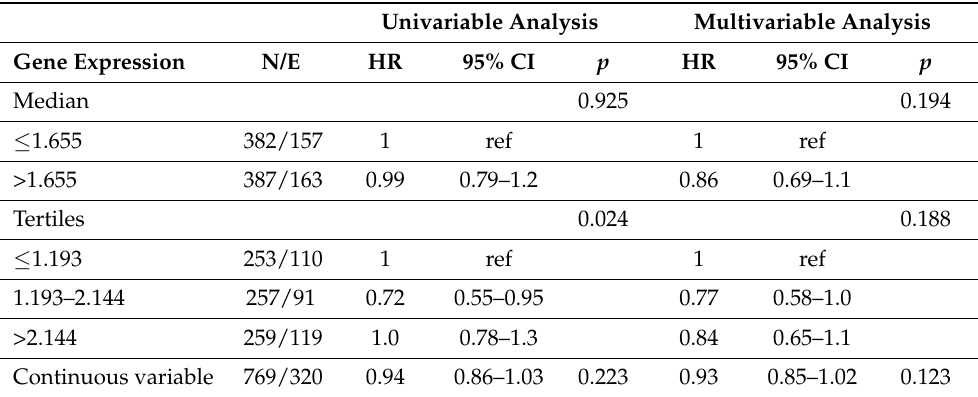
Table 13. Event Free Survival of 769 NB patients in relation to RSAD2 expression levels evaluated by the Cox model.